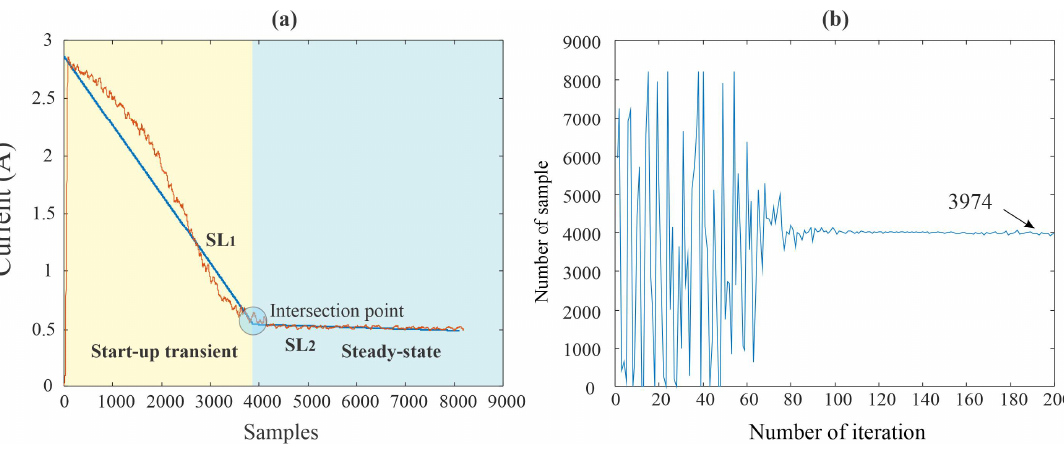
Figure 6. ( a ) The sample estimated by PSO for dividing both regimes and ( b ) the convergence of PSO.